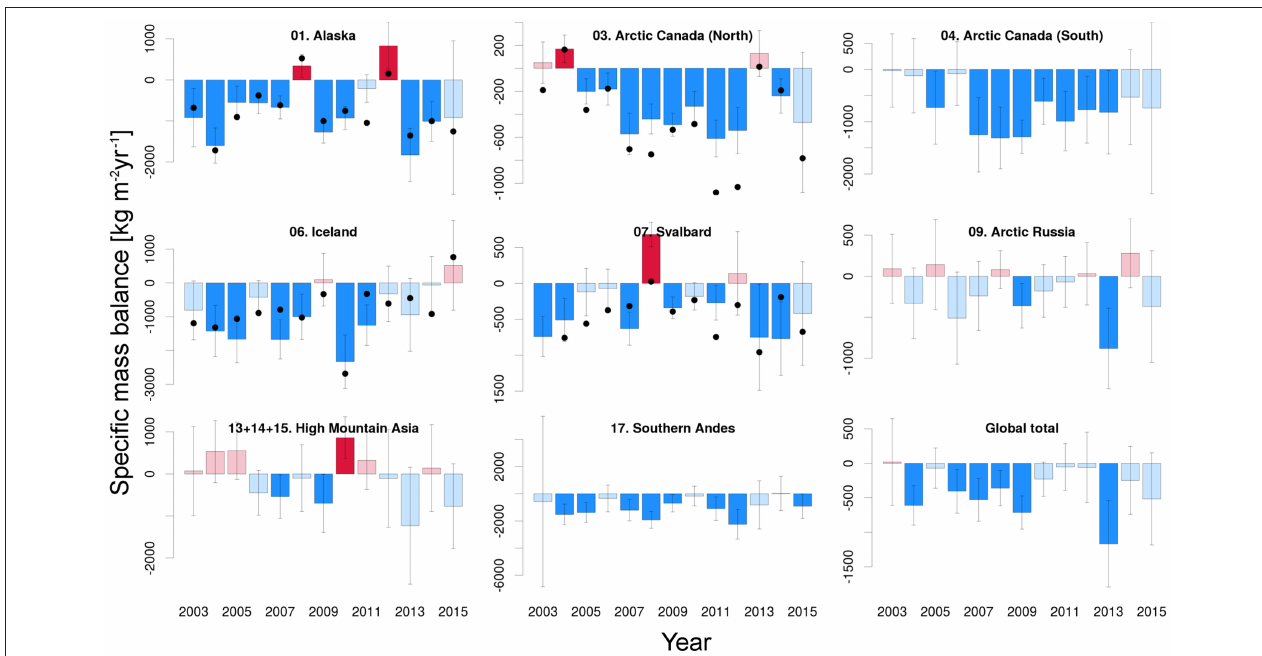
FIGURE 3 | Annual specific mass balance for the larger RGI regions in kg m − 2 yr − 1 . Mass balance years run from October 1 to September 31 for regions in the Northern Hemisphere, and April 1 to March 31 for regions in the Southern Hemisphere. Note the difference in range on the Y-axis between the different subfigures. Values which are not significantly different from zero are plotted in pale colors. Black dots indicate the annual mass balance derived taking the mean mass balance from in-situ observations in the region, where available (see text for details, Figure S2 and Table S3 for station